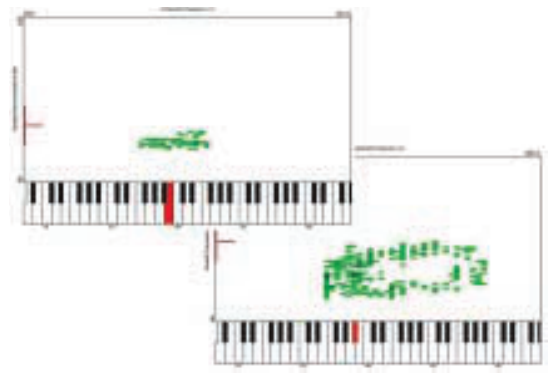
VRP of a 53yr old female patient suffer- ing from non-organic voice disorder before (left) and after (right) voice